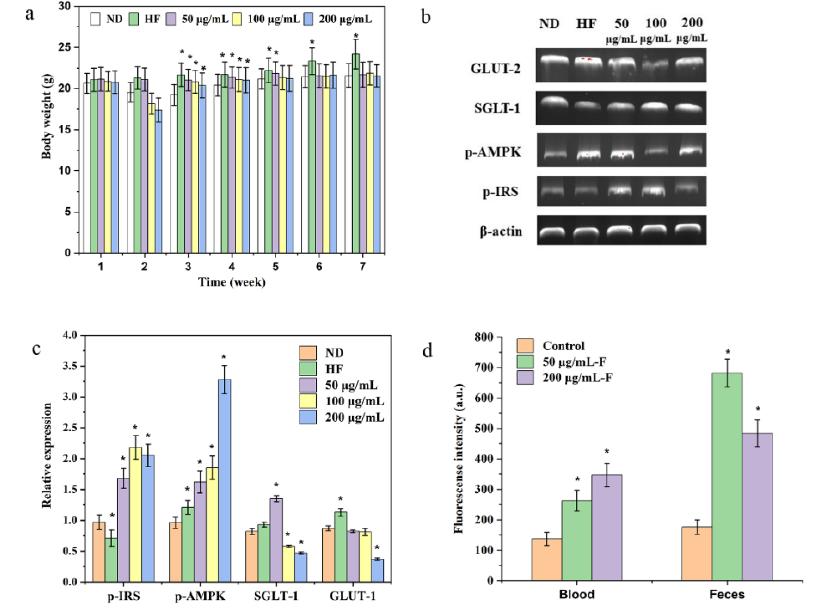
Figure 6. ( a ) Impacts of Pan (50 mg/kg/d) on the BWs of mice. ( b , c ) The expressions of SGLT-1 and GLUT-2 in the intestines and the expressions of p-IRS and p-AMPK in the livers of mice orally given 50, 100 and 200 μg/mL of Pan for 7 weeks. ( d ) Fluorescence intensities of FITC-labeled Pan (50 μg/mL-F and 200 μg/mL-F) in blood/feces. The asterisk (*) indicates the significant differences at p < 0.05 against the ND group or control group.